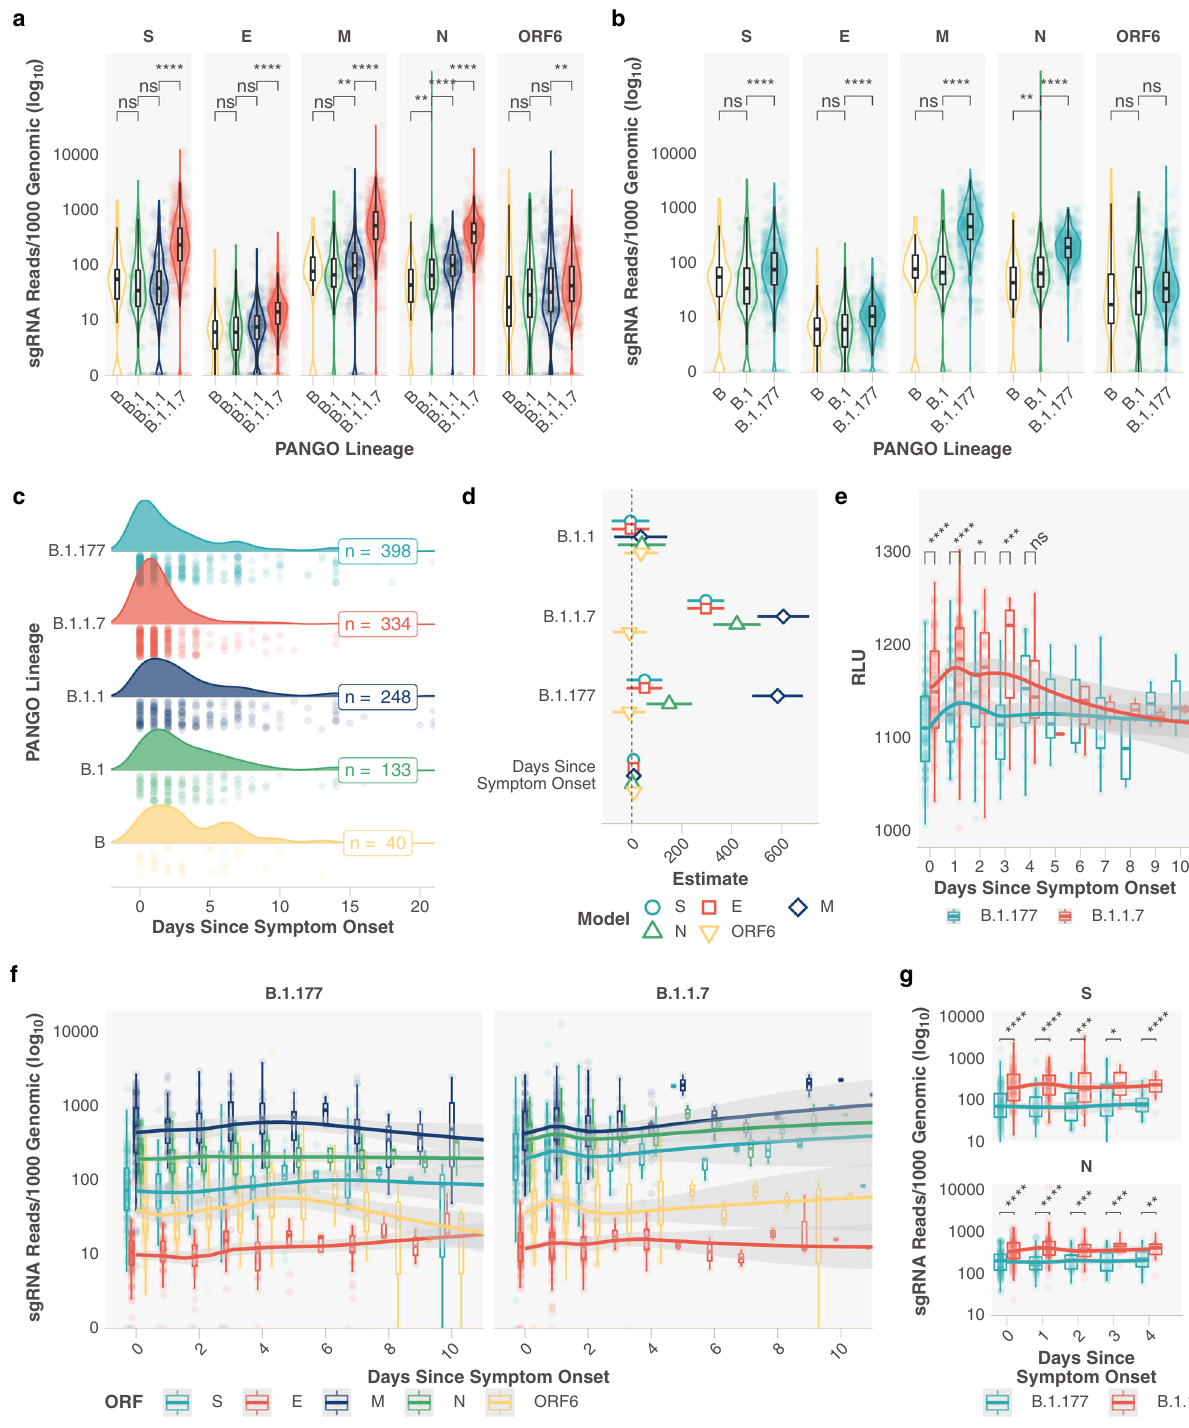
Protein measurements with suf fi cient replicates for